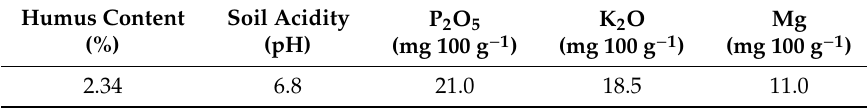
Table 1. Main characteristics of the soil chemical analysis across both growing seasons.